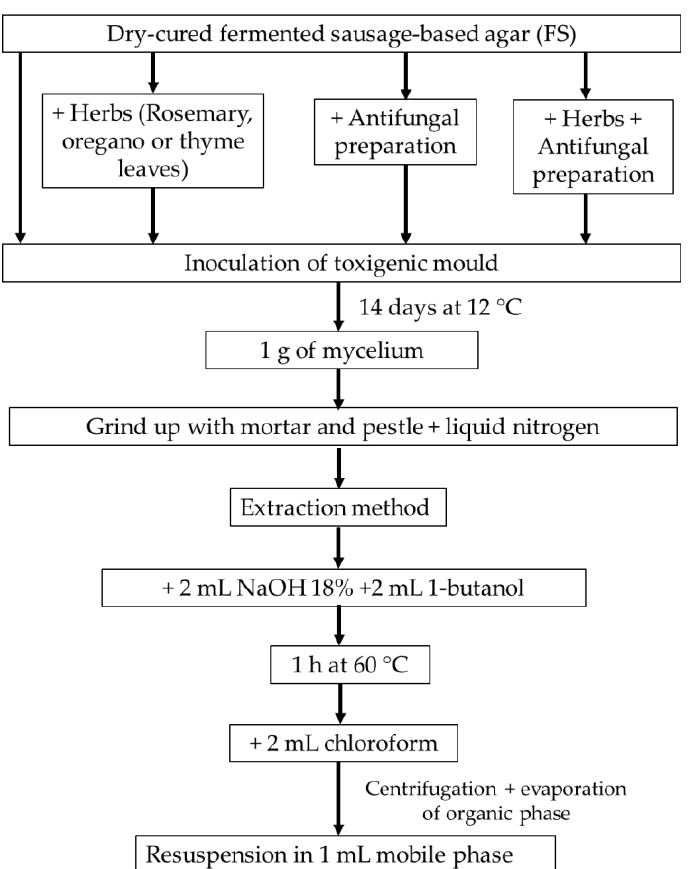
Figure 1. Flow chart showing the assay to check the suitability of the developed methodology for extracting and quantifying ergosterol when determining the effect of antifungal agents against meat product-borne toxigenic moulds. Mobile phase was composed of methanol/acetic acid 0.05% ( v/v ) 95/5 ( v/v ).